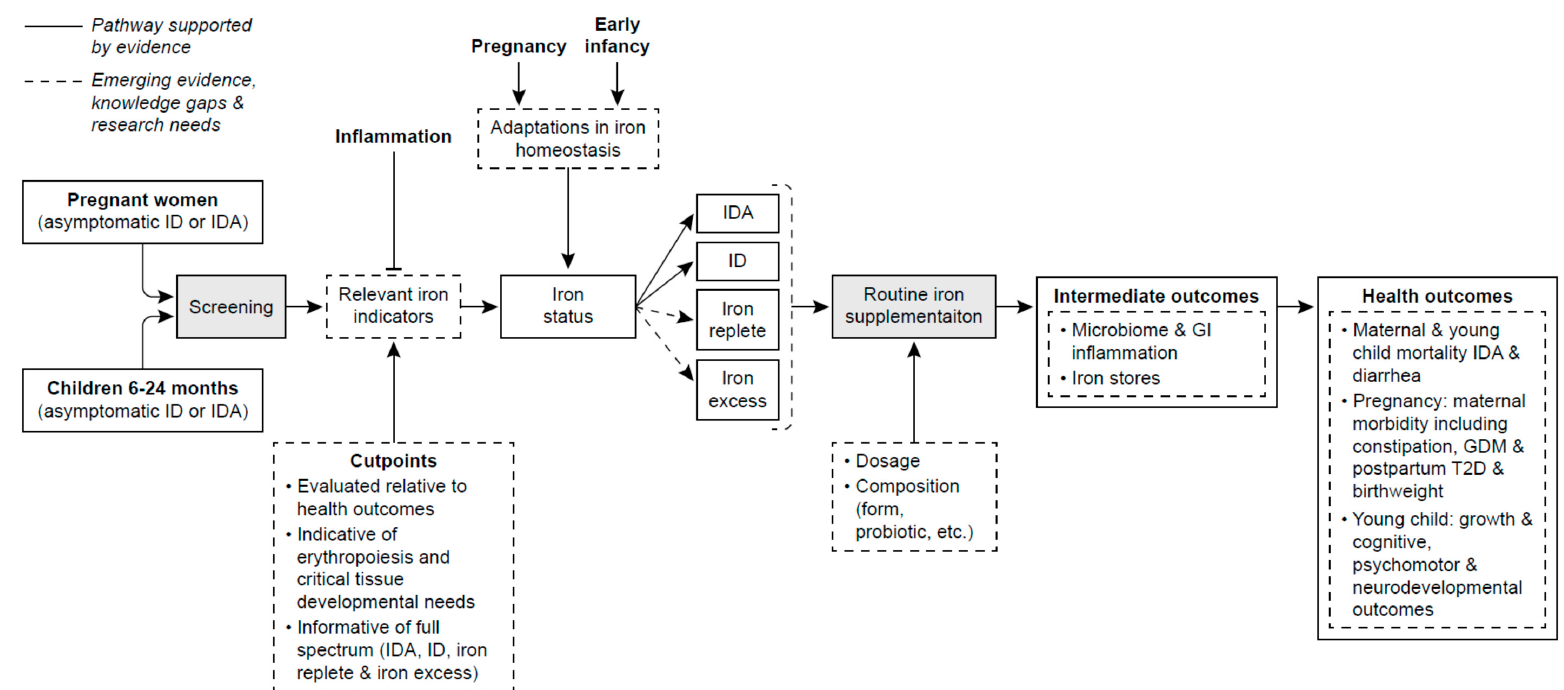
Figure 1. Analytic framework for iron screening and supplementation of pregnant women and young children in developed countries. Solid lines highlight pathways supported by current evidence. Dashed lines highlight emerging evidence, uncertainties and research needs. Abbreviations include ID, iron deficiency; IDA, iron deficient anemia; GI, gastroinestine; GDM, gestational diabetes; T2D, type 2 diabetes. (From Brannon et al. [48] and reprinted with permission by American Journal of Clinical Nutrition: Am. J. Clin. Nutr. 2017; 106(Suppl): 1703S–12S. Printed in USA. © 2017 American Society for